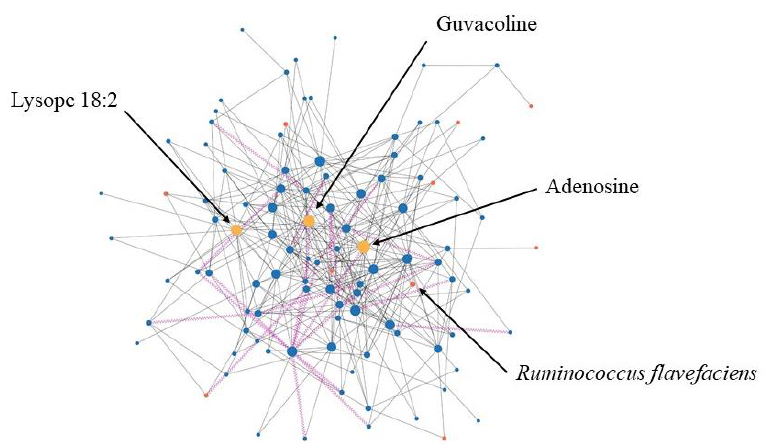
Figure 6. Interaction network of variables selected by RF for integrated analysis of the microbiome and metabolome, where solid lines (grey) and polylines (purple) represent positive correlation and negative correlation, respectively. The blue node and orange node represent metabolites and bacteria species, respectively. The top three nodes with the highest betweenness value are highlighted in